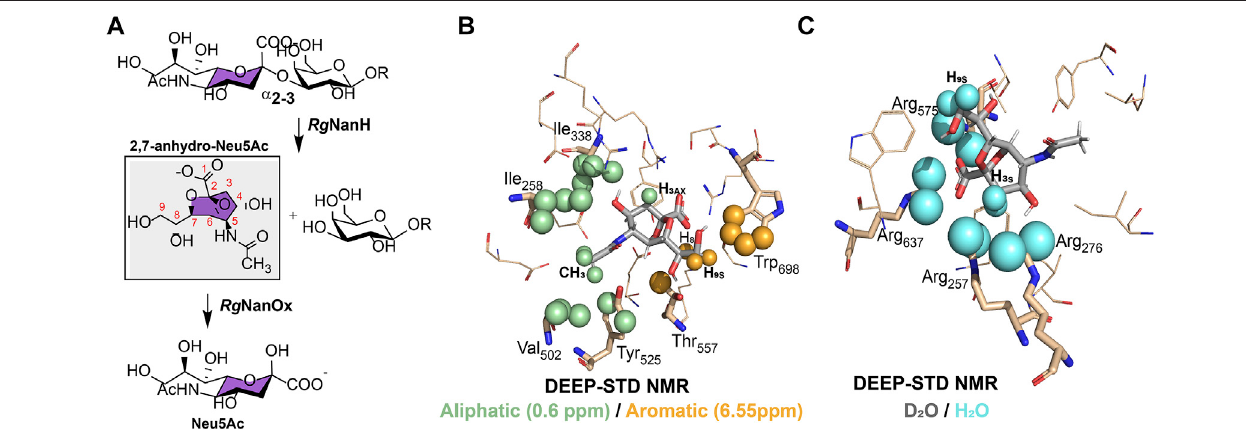
FIGURE 5 | Metabolism and recognition of sialic acid structures by Ruminococcus gnavus ATCC 29149 strain. (A) . Schematic representation of the enzymatic processing of α 2,3-linked sialic acid compounds to 2,7-anhydro-Neu5Ac by Rg NanH and reversible conversion of 2,7-anhydro-Neu5Ac to Neu5Ac by Rg NanOx. (B) and (C) . Differential epitope mapping of 2,7-anhydro-Neu5Ac in complex with Rg NanH-GH33. The crystal structure of the complex (PDB ID: 4 × 4A) (Tailford et al., 2015b). (B) . DEEP – STD map (0.60/6.55 p.p.m) of 2,7-anhydro-Neu5Ac. Green spheres highlight ligand contacts with aliphatic side chains, and orange spheres represent contacts with aromatic side chains. (C) . DEEP – STD map (D 2 O/H 2 O) of 2,7-anhydro-Neu5Ac. Cyan spheres show ligand contacts with protein side chains carrying slow exchanging protons. Adapted from Monaco et al.